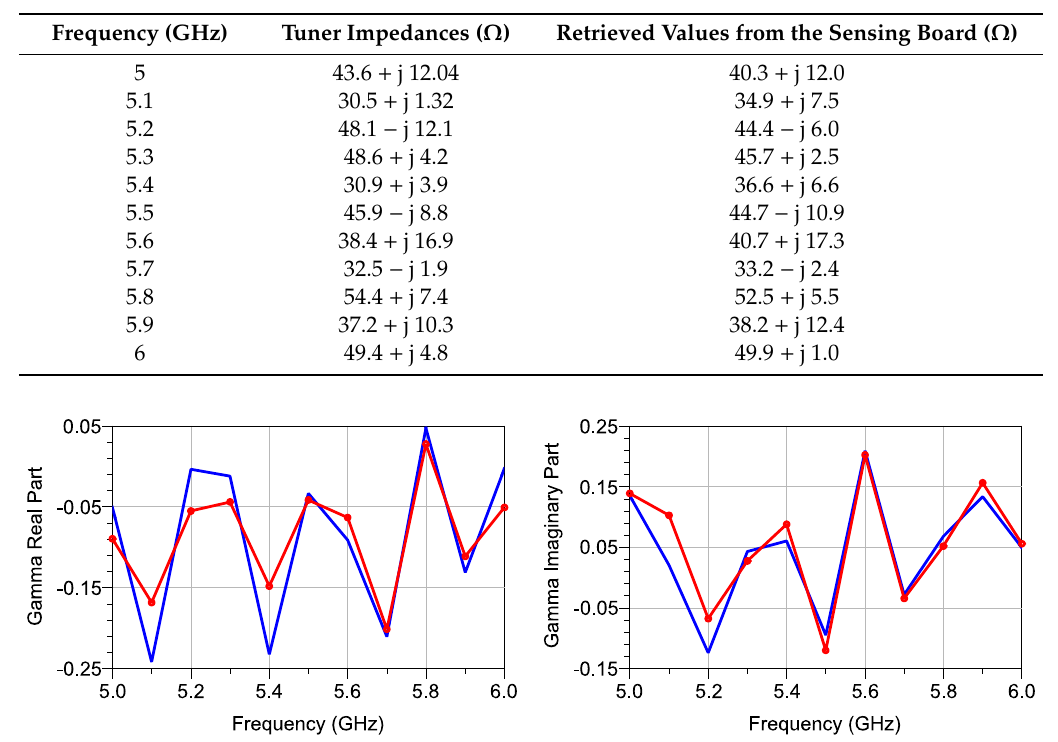
Table 2. Impedance Measurement Results.